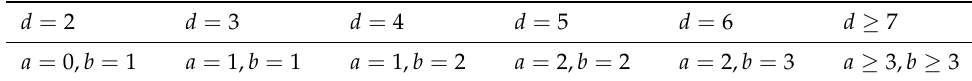
Table 2. Diameter determined by the values of a and b